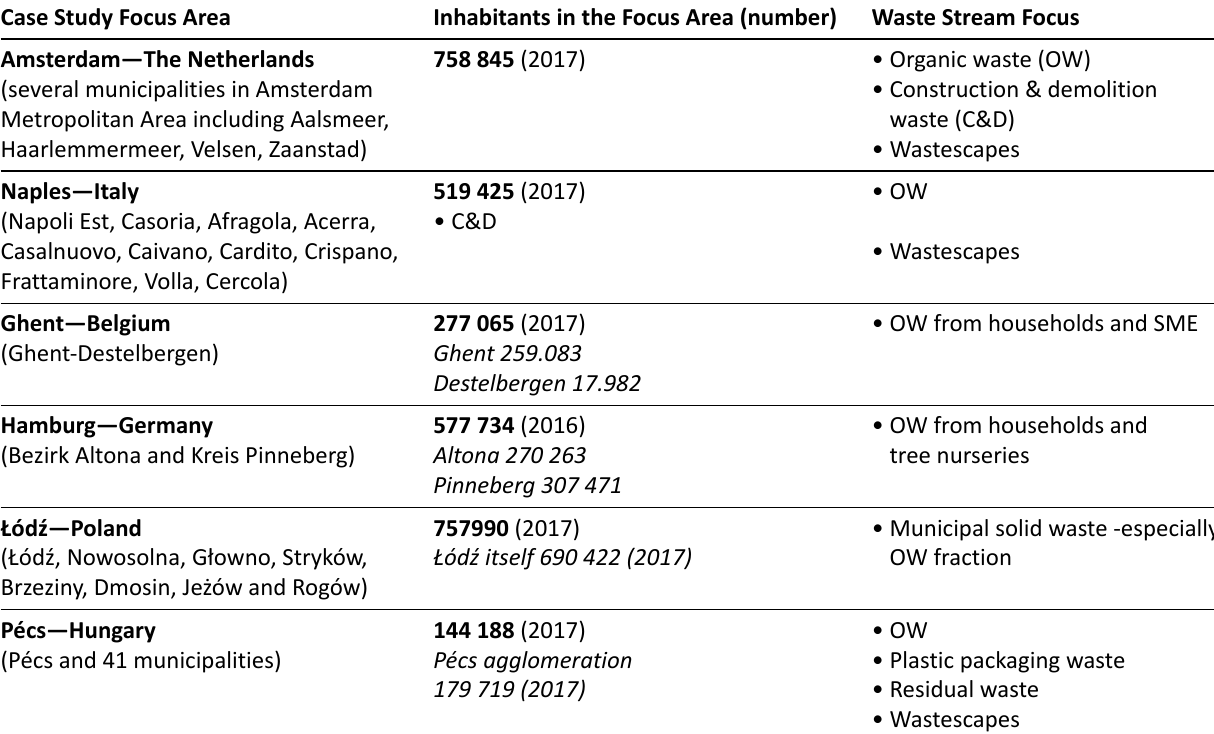
Table 1. Overview of the six focus areas in REPAiR project. Focus area indicates arbitrarily predetermined zones which contain peri-urban